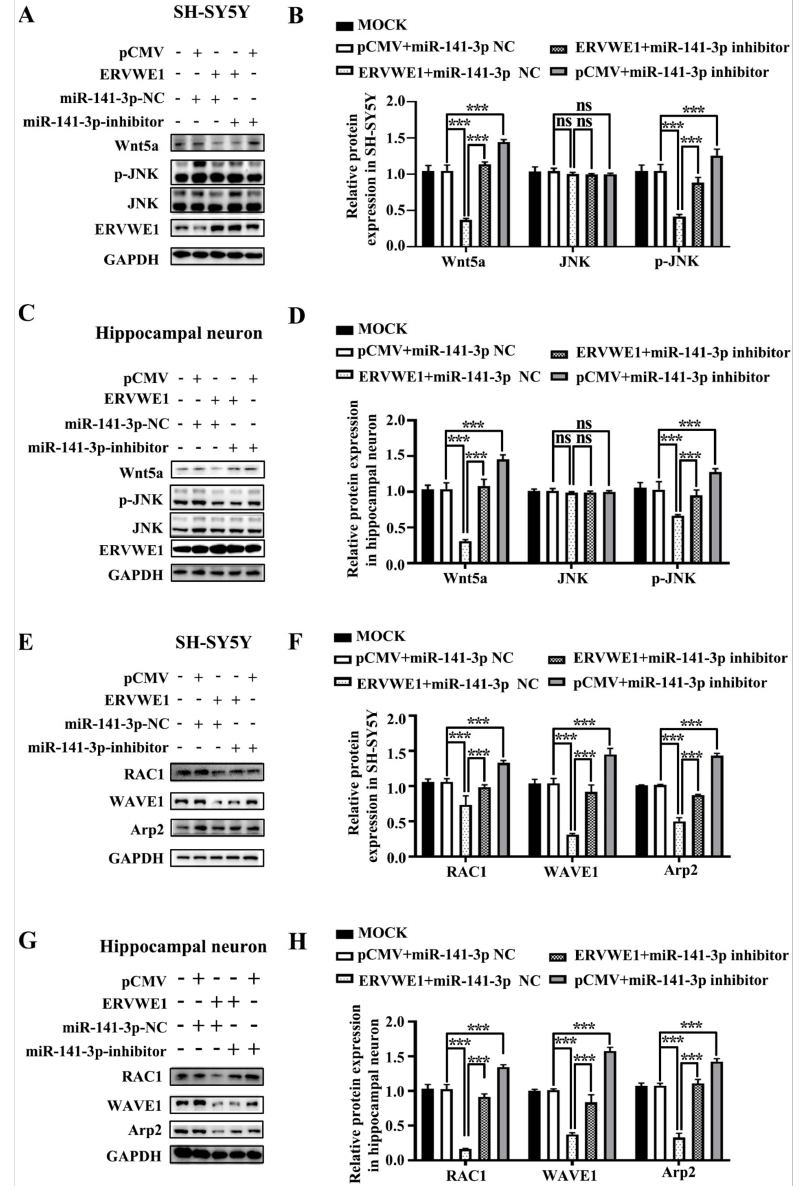
Figure 5. MiR-141-3p mediated the inhibition of the JNK non-canonical signal pathway induced by ERVWE1. ( A , B ) Western blot results showed that knockdown of miR-141-3p substantially elevated the ERVWE1-induced protein expression of p-JNK in SH-SY5Y cells. ( C , D ) In rat hippocampal neurons, miR-141-3p knockdown resulted in an increase in p-JNK proteins induced by ERVWE1. ( E , F ) In SH-SY5Y cells, miR-141-3p knockdown significantly increased the expression of RAC1, WAVE1, and Arp2 induced by ERVWE1. ( G , H ) The knockdown of miR-141-3p significantly in- creased the expression of RAC1, WAVE1, and Arp2 in rat hippocampal neurons induced by ERVWE1. *** p < 0.001, ns: p >